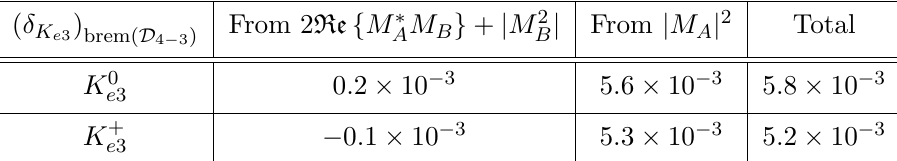
Table 5 . The bremsstrahlung contribution in the D 4 − 3 region. Uncertainties are of order 10 − 5 and are not